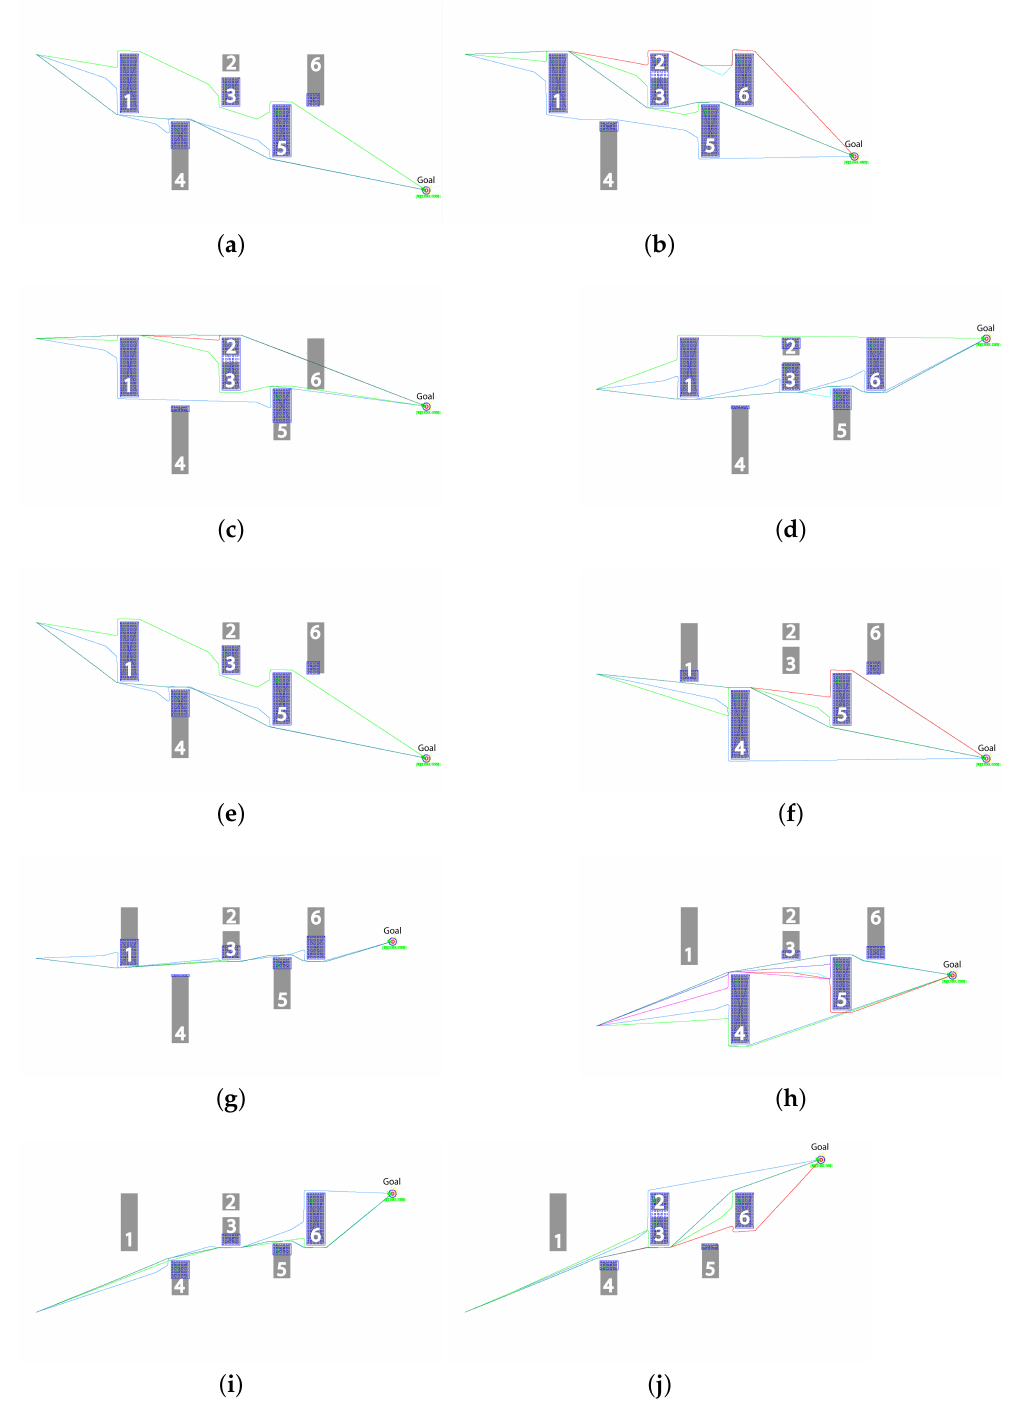
Figure 6. Simulation results: different experimental scenarios. ( a ) Experimental scenario 1. ( b ) Ex- perimental scenario 2. ( c ) Experimental scenario 3. ( d ) Experimental scenario 4. ( e ) Experimental scenario 5. ( f ) Experimental scenario 6. ( g ) Experimental scenario 7. ( h ) Experimental scenario 8. ( i ) Experimental scenario 9. ( j ) Experimental scenario